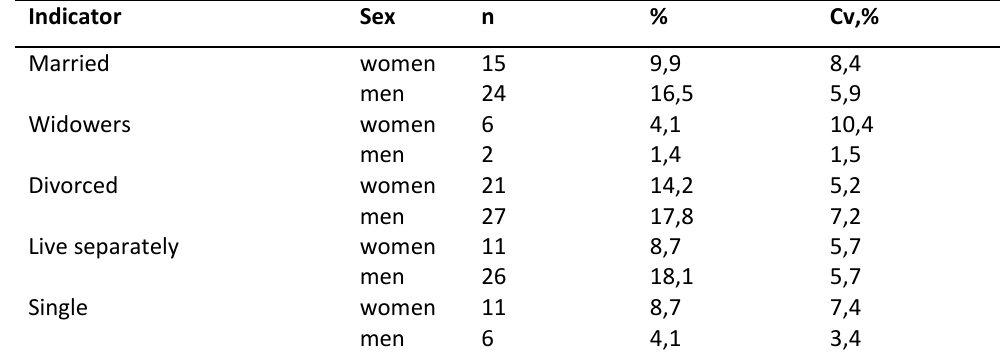
Table 3. Marital status of respondents, depending on sex